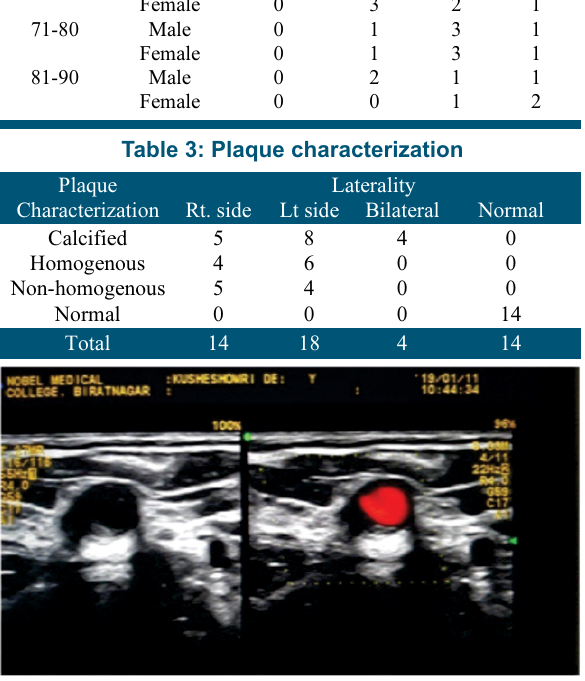
Figure 9: Non signicant stenosis of CCA